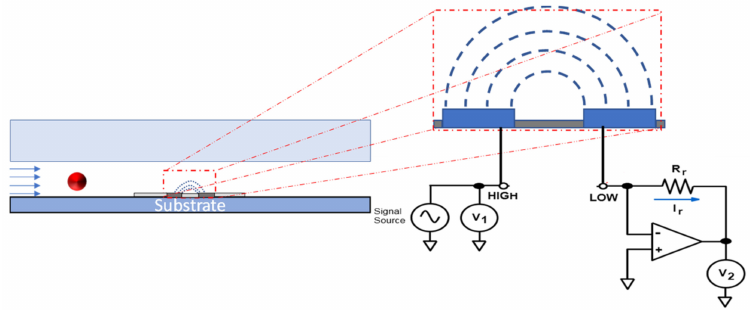
Figure A3. Measurement principle and method of coplanar microsensor. Microbeads are inserted into the microfluidic channel using syringe and needle, and the impedance measurements are performed using the method of Auto-Balancing